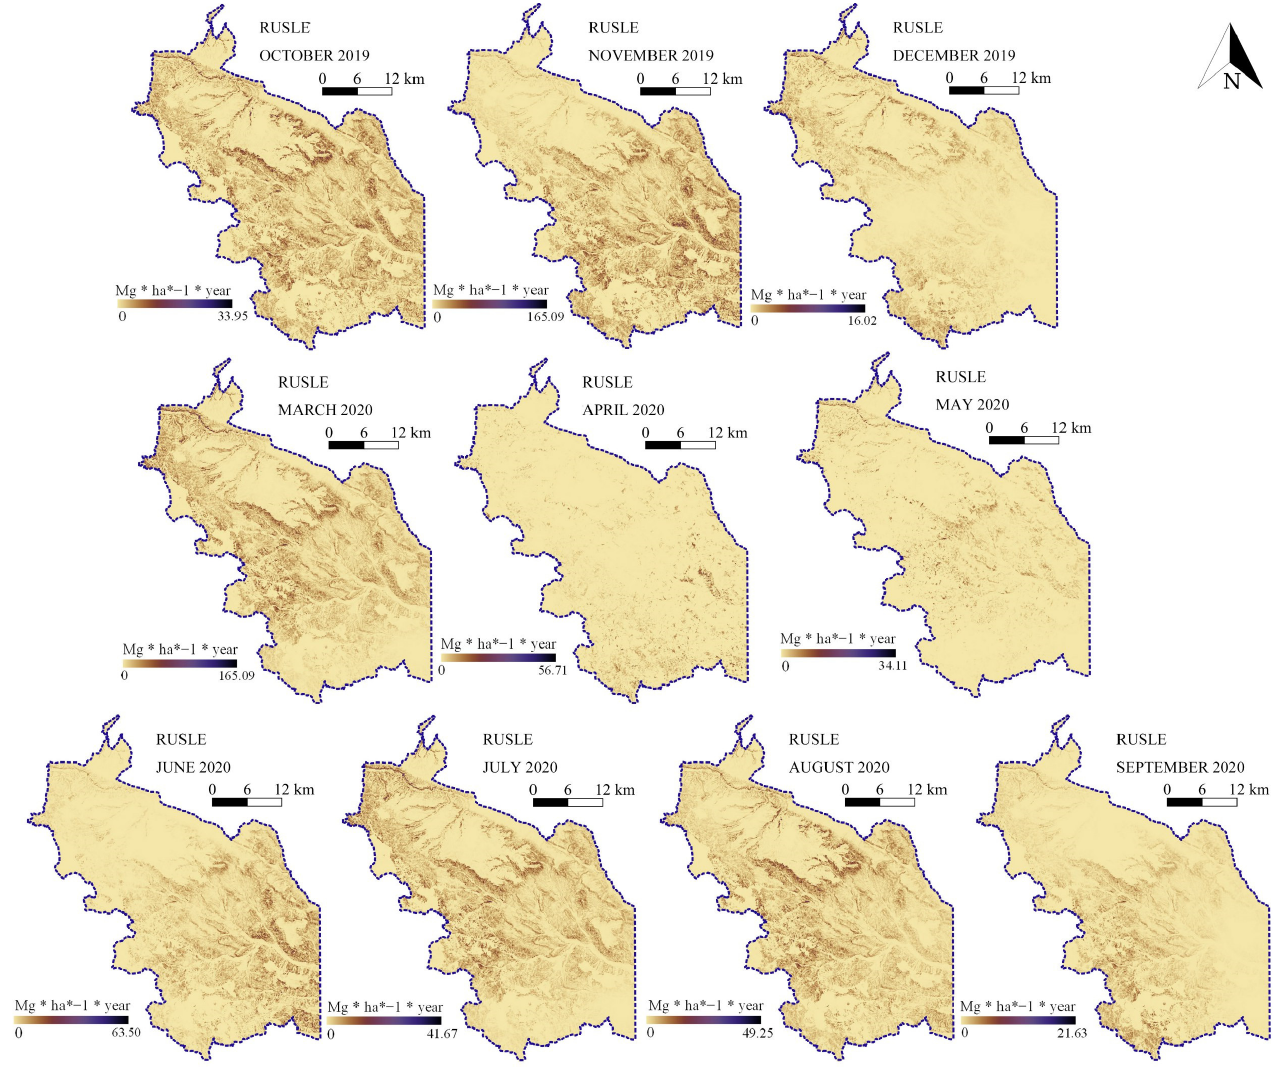
Figure 5. Example of the results of the parameters used for calculating the RUSLE. For R and C Factors, only one monthly run was reported as an example.